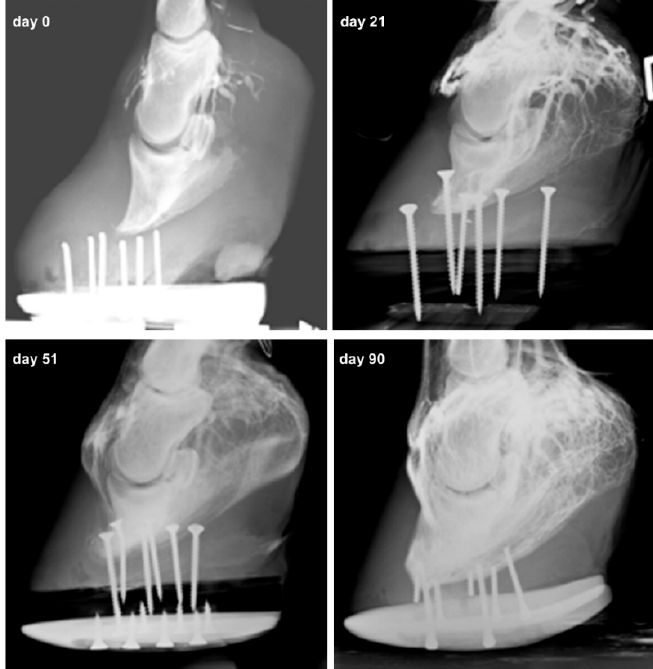
Figure 1. Case 2: Venograms of the right foot affected by laminitis at different time points. At 21 days after the first aMSC/PRP treatment, an increase in venous filling is observed. The venographic appearance of the digital vascular bed showed restored vascularization of the foot 90 days after the first aMSC/PRP treatment.